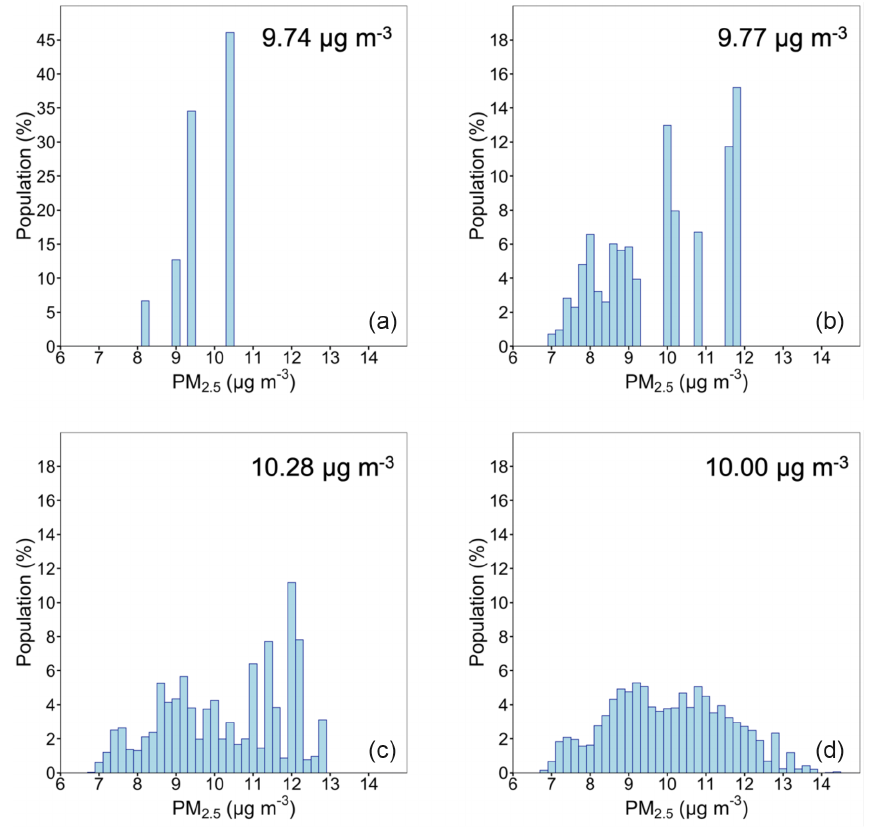
Figure 12. Population exposure histograms at (a) 36 × 36, (b) 12 × 12, (c) 4 × 4, and (d) 1 × 1km during February 2017. A different scale for population is used for the distribution at 36 × 36km resolution. The average population-weighted PM 2 . 5 concentration for each resolution is shown in the upper right corner of each